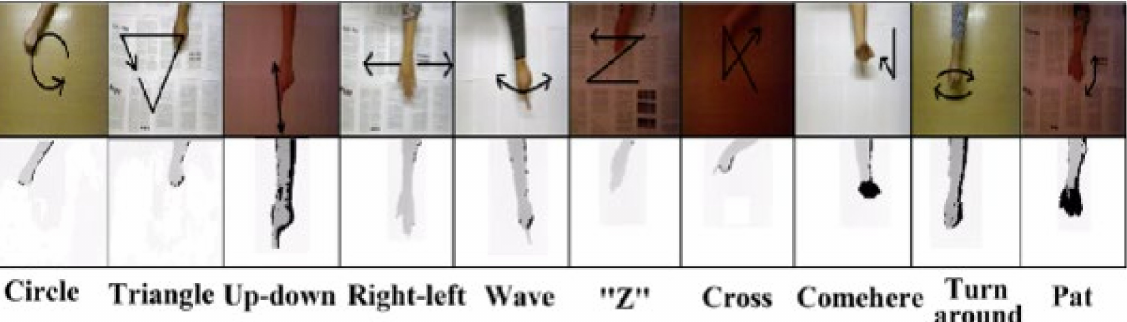
Figure 11. Image frames from SKIG Dataset.